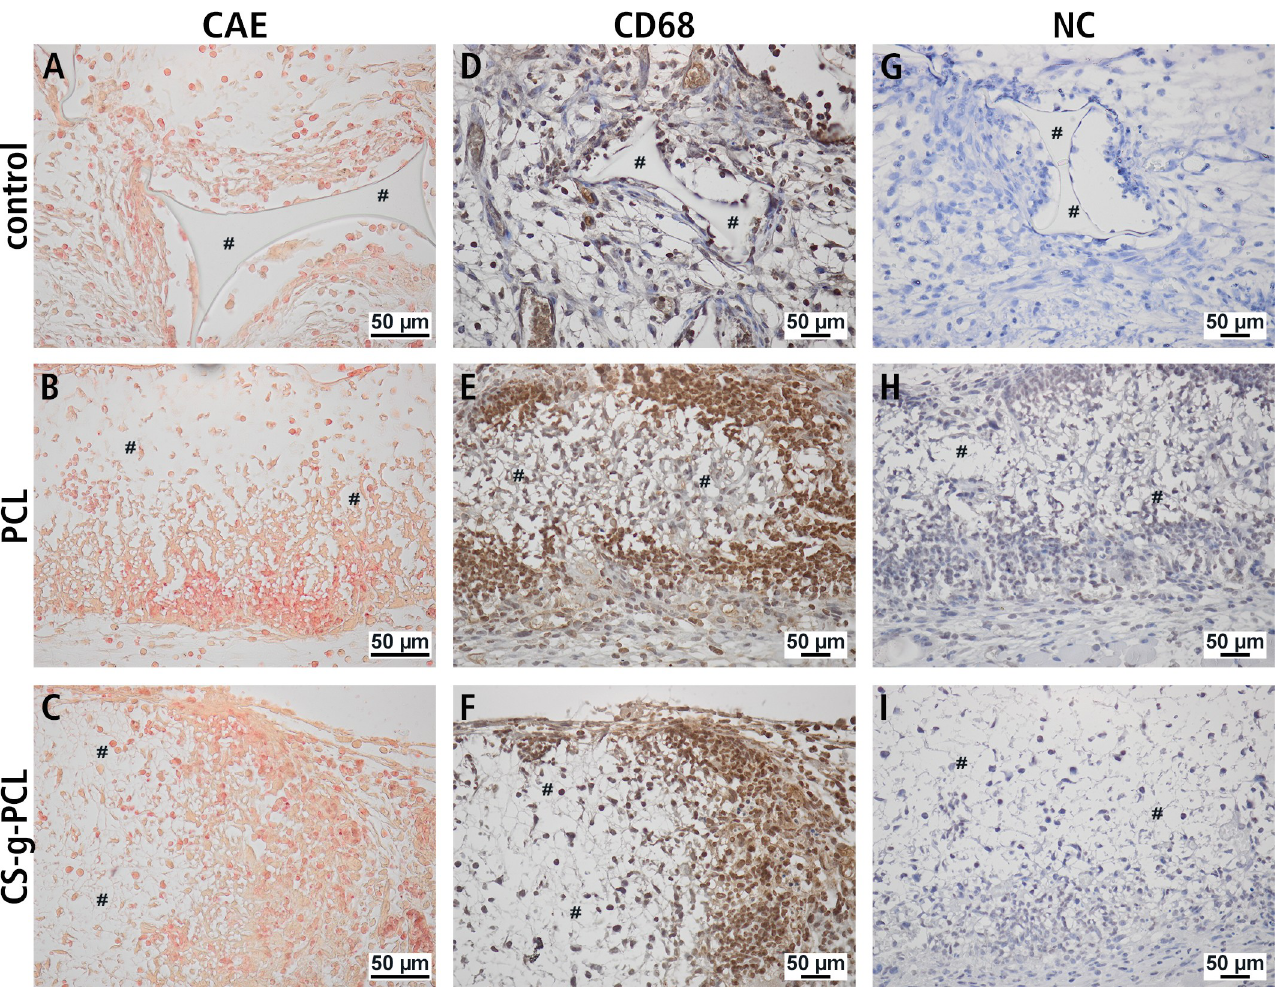
Fig 6. Naphtol-AS-D-chloroacetate esterase staining and immunohistochemical detection of CD68. Representative histological staining of neutrophilic granulocytes (A-C) 14 days after implantation into the dorsal skinfold chamber of BALB/c mice using naphtol-AS-D-chloroacetate-esterase (CAE) staining. Representative histological staining for detection of macrophages and monocytes (D-I) 14 days after implantation into the dorsal skinfold chamber of BALB/c mice. (D-F) Immunohistochemical detection of CD68 for detection of macrophages. (G-I) Negative controls. Areas of the implant are marked (#) .